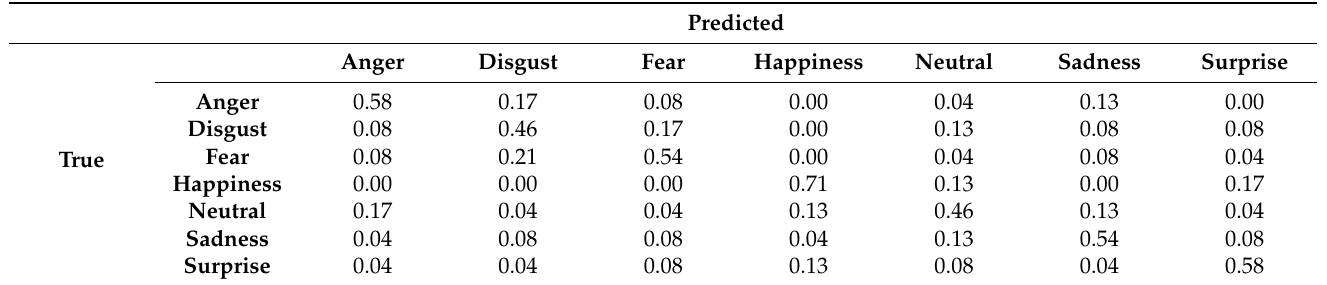
Table 4. Numbers of emotion samples used in the training phase.